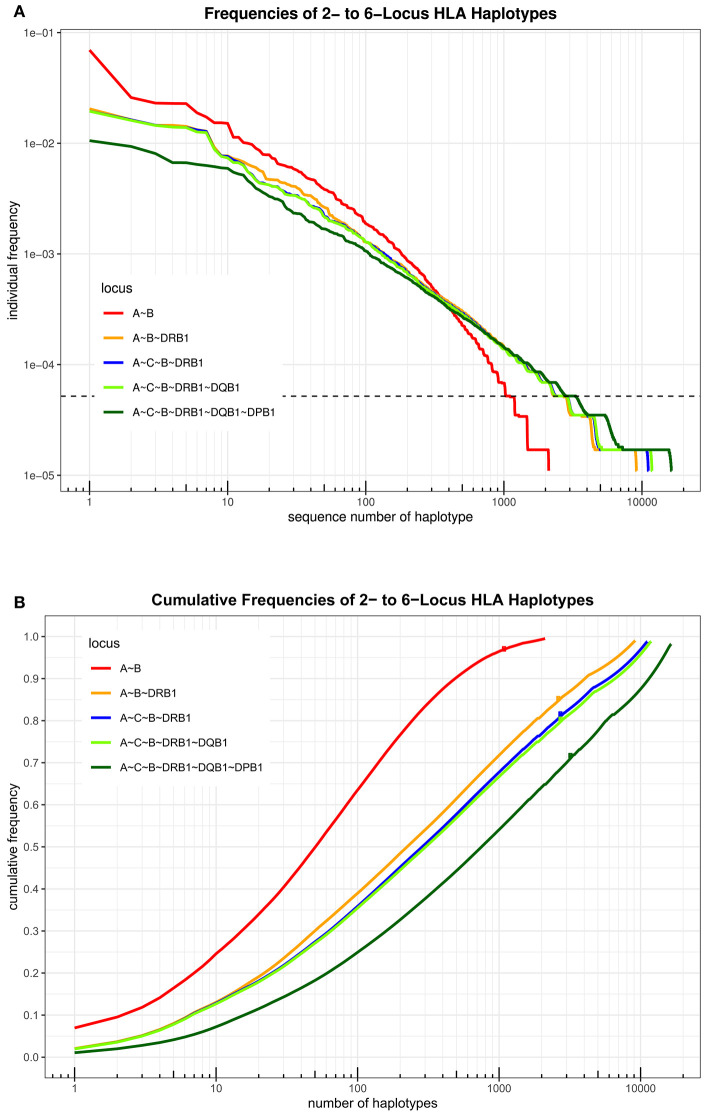
(A) The haplotypes of each set of loci are ordered by descending frequency on the x-axis, and the curve shows their frequency. Both axes are in logarithmic scale. The dotted horizontal line shows the frequency corresponding to three copies in the sample. (B) For each number n on the x-axis in logarithmic scale, the curve depicts the cumulative frequency of the set of the n most frequent haplotypes of each locus combination. The dots on each curve mark the cumulative frequency of all haplotypes seen at least three times in the sample.